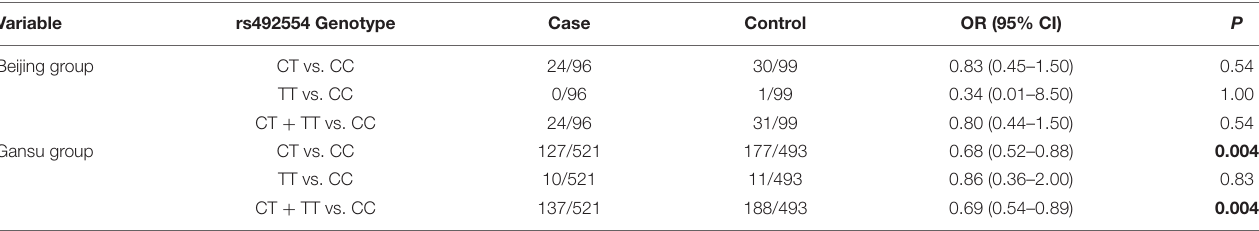
TABLE 2 | Association of rs492554 polymorphism and CHD in two independent case-control